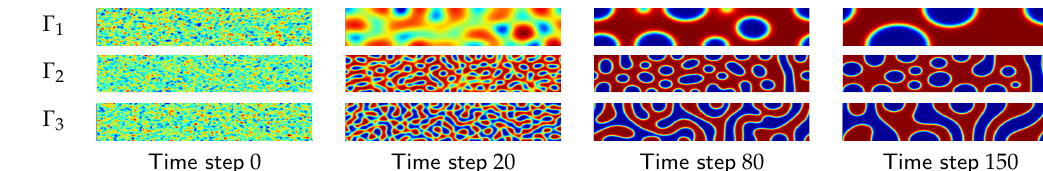
Figure 1. High-dimensional process data trajectories generated by a material morphology simulation. Each row corresponds to the instances sampled at different time points from a single trajectory. Each trajectory Γ I corresponds to different variants of the organic thin film fabrication process (described by parameters φ and χ ): Γ 1 = Γ ( φ = 0.6, χ = 2.2 ) , Γ 2 = Γ ( φ = 0.6, χ = 3.0 ) , Γ 3 = Γ ( φ = 0.5, χ = 3.0 ) . Each image is a high-dimensional point capturing material morphology (different colors represent different types of polymer making the material). (Please view in